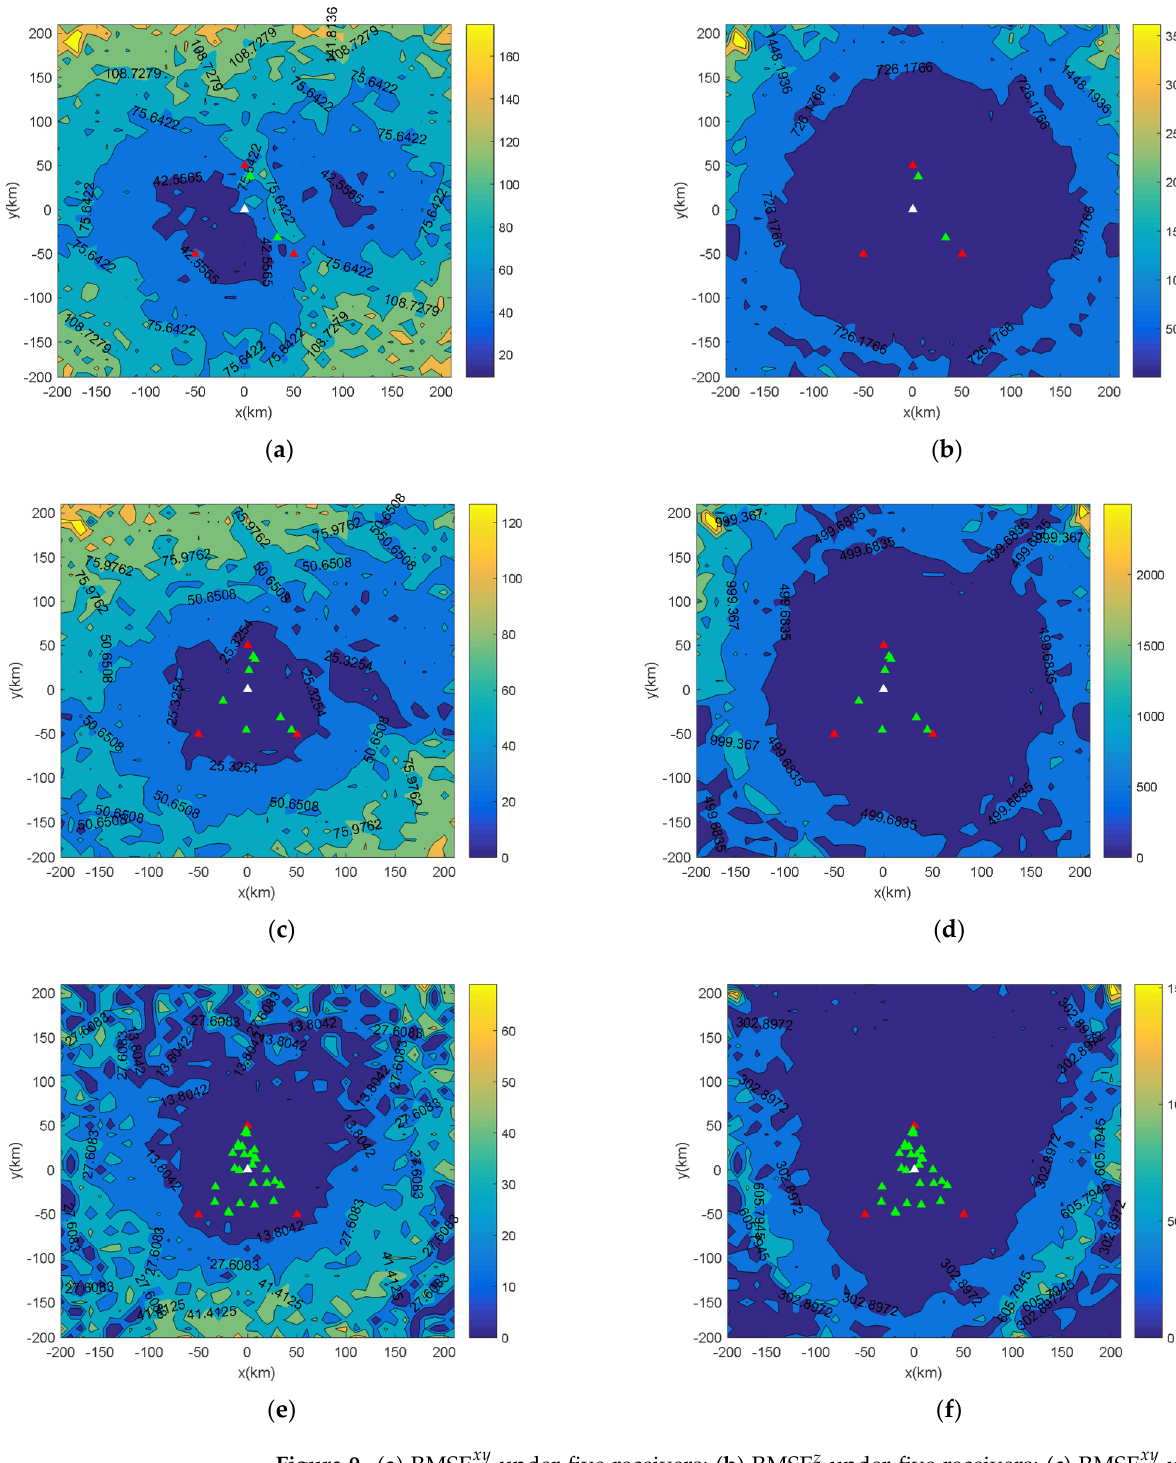
Figure 9. ( a ) RMSE xy under five receivers; ( b ) RMSE z under five receivers; ( c ) RMSE xy under 10 receivers; ( d ) RMSE z under 10 receivers; ( e ) RMSE xy under 30 receivers; ( f ) RMSE z under 30 receivers. The location errors under the 100 × 100 × 100 m grid step. The triangles indicate the receivers’ locations. The white triangle shows locations at the origin, and the three red triangles form a triangle that covers the others, whose color is